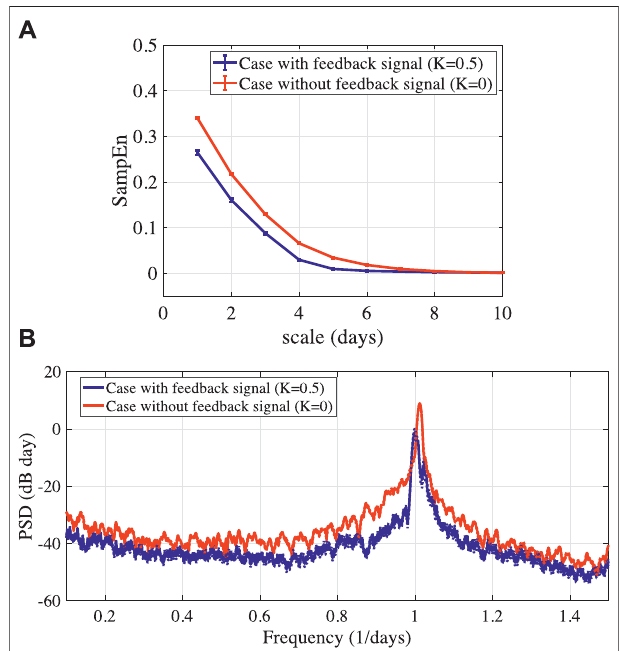
FIGURE 5 | (A) MSE analysis of stabilized circadian rhythms output( k ) given by Eq. (8) in BD ( A (cid:1) 15 . 0 , K (cid:1) 0) and stabilized ( A (cid:1) 15 . 0 , K (cid:1) 0 . 5) cases. ThemeanandstandarderrorofSampEnin10trialsareshownbysolid line and error bar respectively. (B) PSD of circadian rhythm output( k ) in BD and stabilized cases. The mean and standard error of PSD were indicated by solid and dotted lines, respectively. In MSE analysis, with feedback signals ( K (cid:1) 0.5), SampEn in the scale ( ( 7 days) is lower, compared to the case without feedback signal ( K (cid:1) 0). Along with it, the power spectrum analysis showed that under the feedback signal ( K (cid:1) 0.5), the PSD in ( 1, a 1 [1/day] decreased than the case without feedback signal ( K (cid:1) 0).